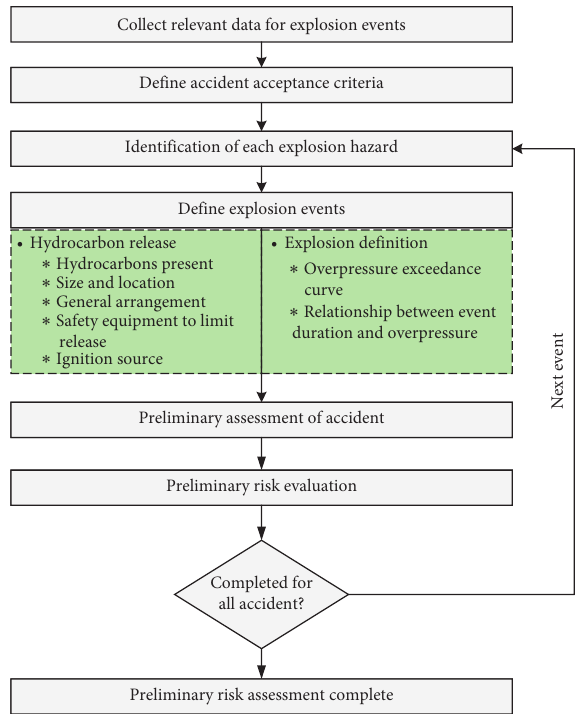
Figure 1: Role of defining explosion loads in risk assessment process.